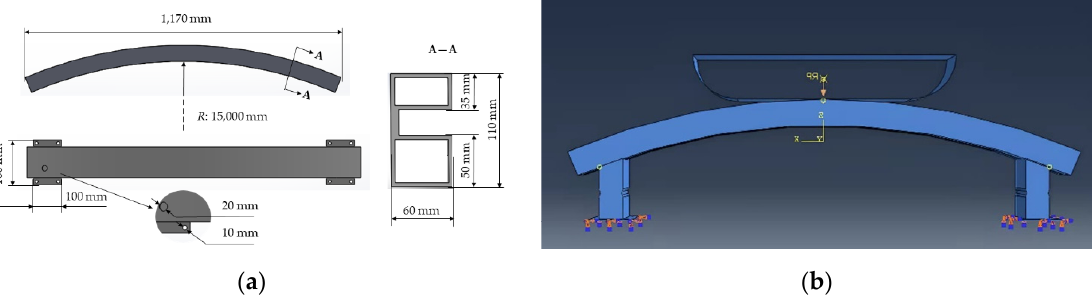
Figure 7. ( a ) Geometry of car bumper beam; ( b ) boundary condition of car bumper beam in ABAQUS.